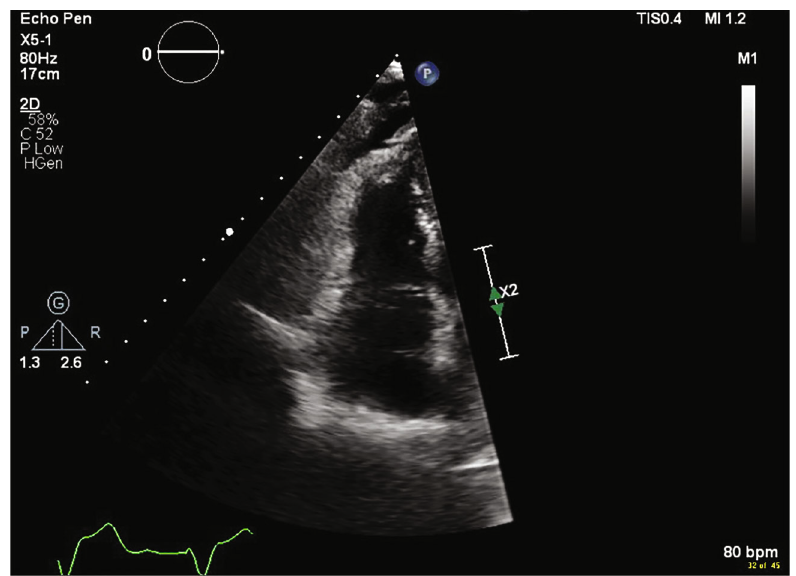
Figure 5: Transthoracic echocardiogram revealing